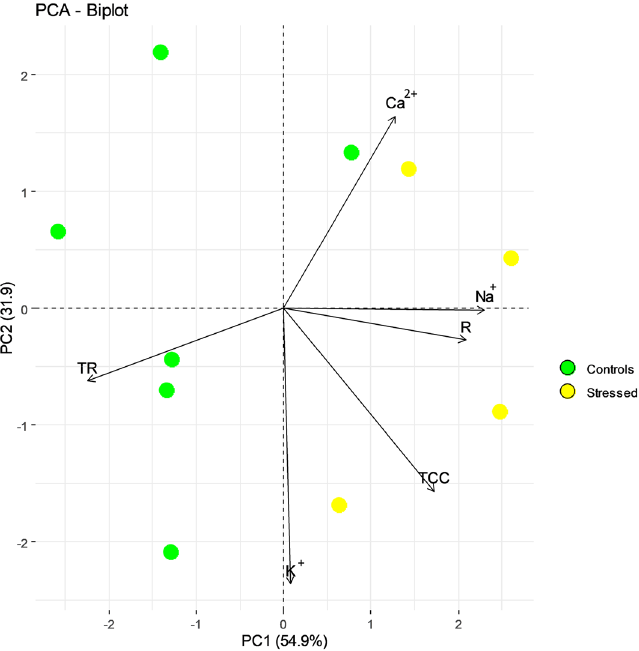
Figure 5. Biplot of the PCA results. The first two PCs display 86.8% of the total physiological variation. The component scores are coloured according to the agronomic groups (yellow dots, stressed plants; green dots control plants). The components loading vectors were proportionally superimposed to their contribution, and their direction indicated the influence of variable group. R, bioristor Response; Na + , sodium concentration; K + , potassium concentration; Ca 2+ , calcium concentration and TCC, total cations concentration measured in Arundo leaves; TR, transpiration rate.